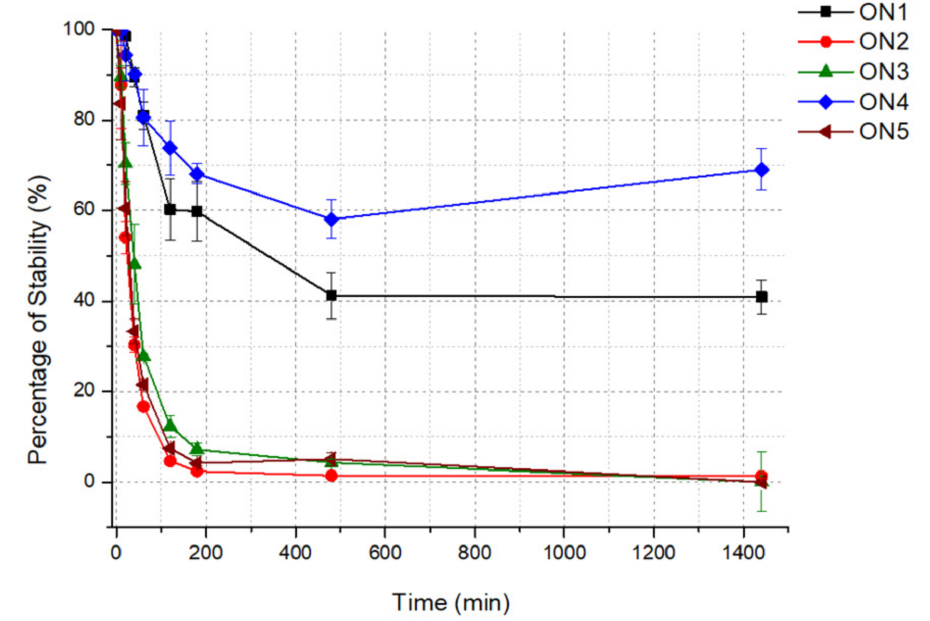
Figure 5. Stability of the oligonucleotides ON1 to ON5 studied in human serum at 1 pmol of